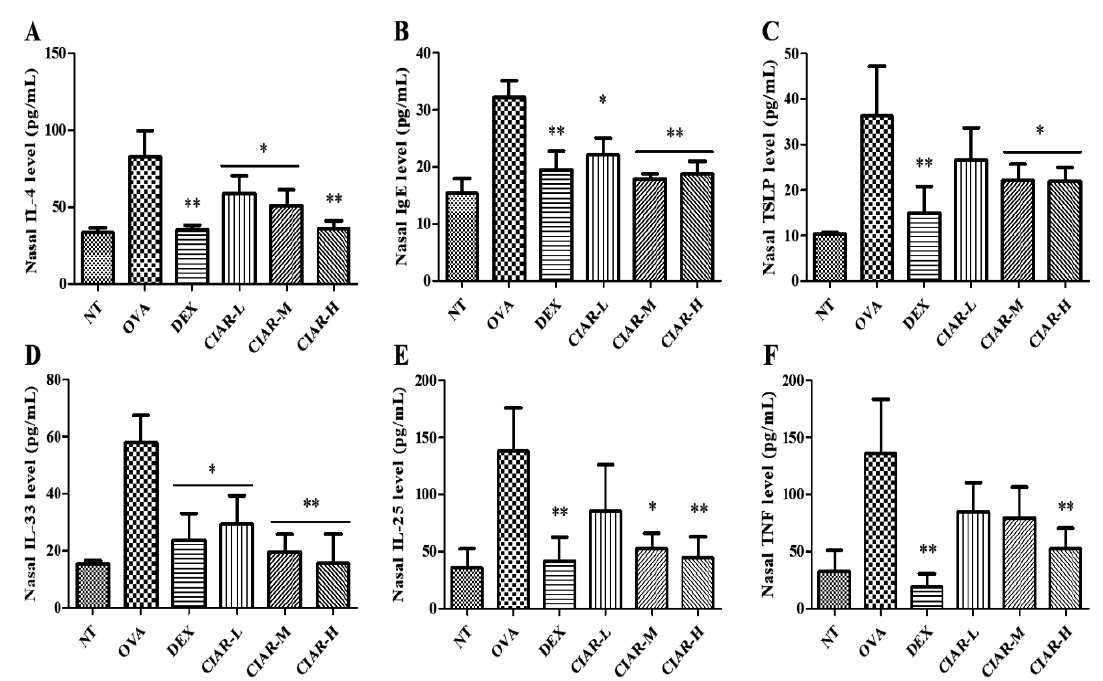
Figure 3. Effects of Th-2 related signal level of CIAR on nasal fluid of mice with ovalbumin-induced allergic rhinitis. Effect on ( A ) IL-4, ( B ) IgE, ( C ) TSLP, ( D ) IL-33, ( E ) IL-25, and ( F ) TNF levels in nasal fluid samples. Data are shown as the mean ± SE. Significant differences are indicated as * p < 0.05 and ** p < 0.01, compared to the OVA group. NT—normal mice; OVA—OVA-exposed mice; DEX—